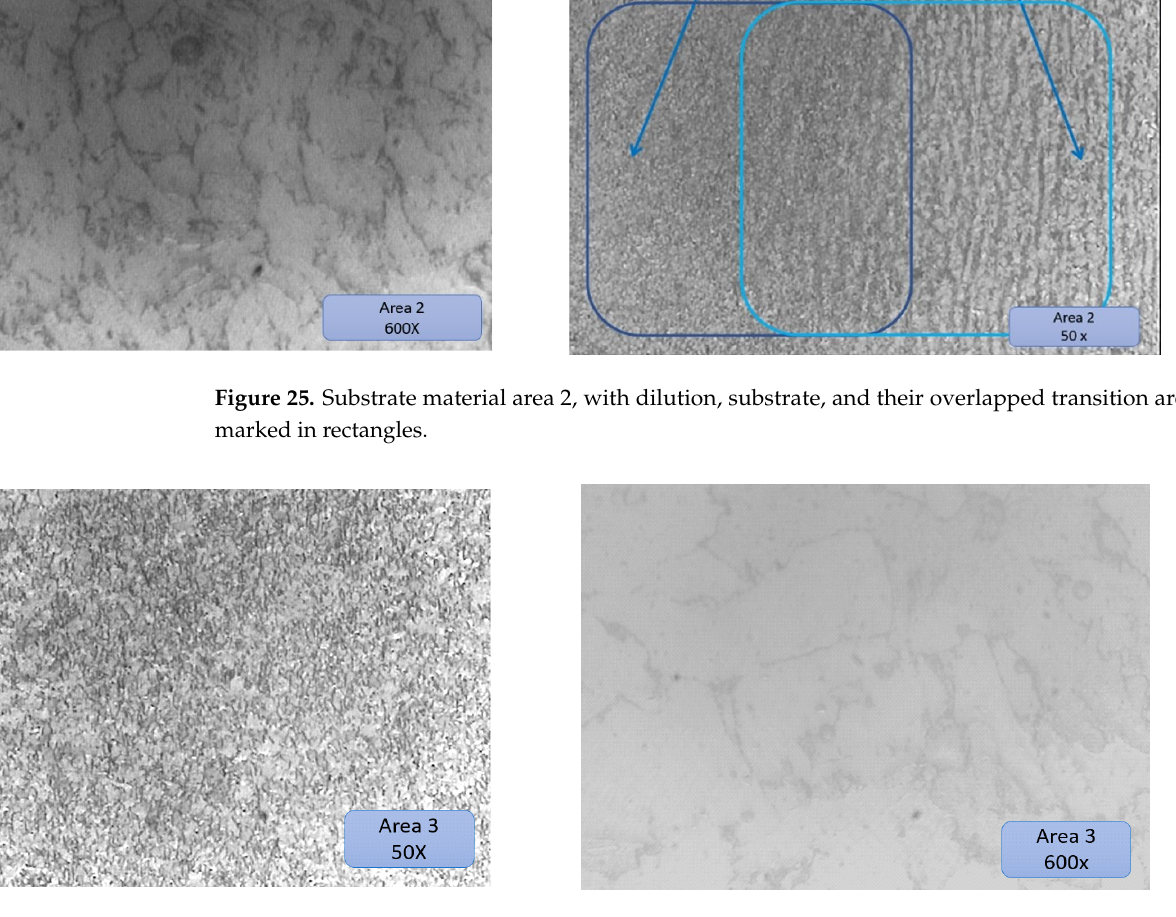
Figure 27. Comparison between the calculated part weight and the weight obtained. 4. Manufacturing Costs Using WAAM Materials Table 4 shows the detailing of the costs of the raw material used to produce the com- ponent as well the calculation of the rate of use of the material. As can be seen, the total weight of the raw part was 4185 gr, and after being needed to machine the workpiece, the